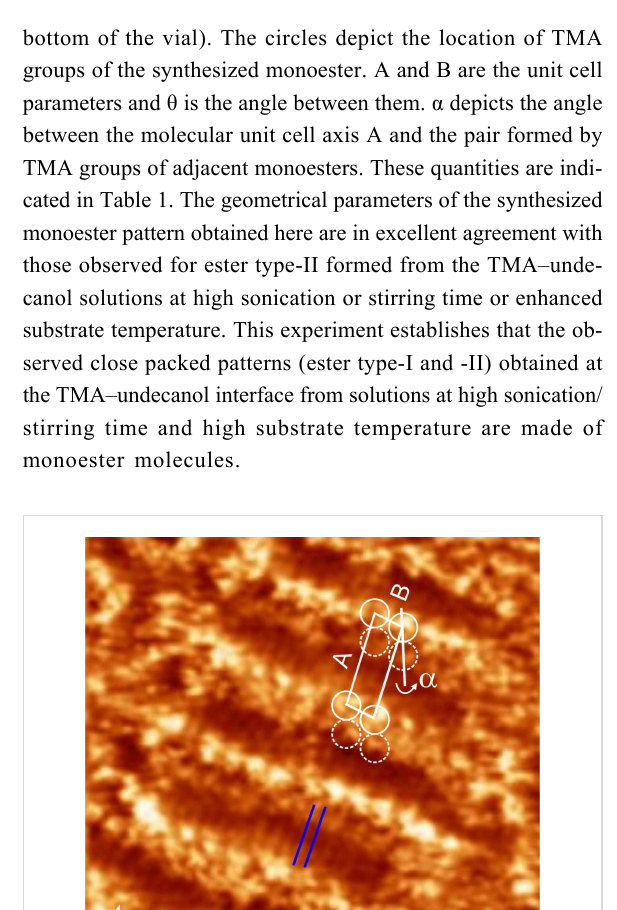
Figure 6: Simulation of the STM constant height mode images (HOMO (a) and LUMO (b)) of a single monoester molecule.